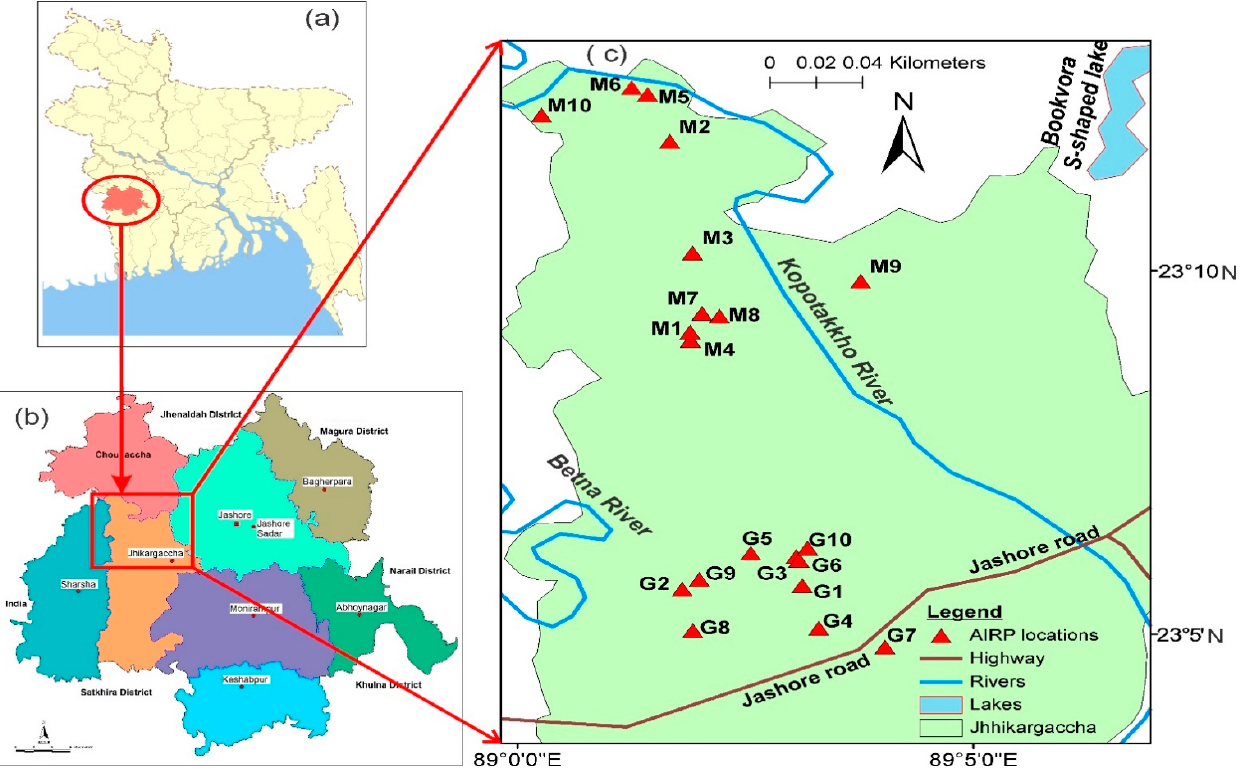
Figure 2. Study area map. ( a ) Location of Jashore district in Bangladesh; ( b ) Jashore district; ( c ) sampling location in Ganganandapur (indicated by “G”) and Magura (indicated by “M”) in Jashore district.